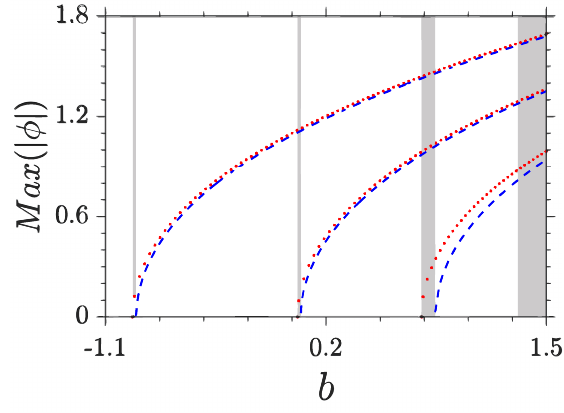
Figure 3. Amplitudes of NLBWs versus b . Shaded areas are linear bands and white regions are bandgaps. Dotted (red) and dashed (blue) lines denote NLBWs bifurcating from LBWs at the BZ centers and edges, respectively. p = 1.5 and α =